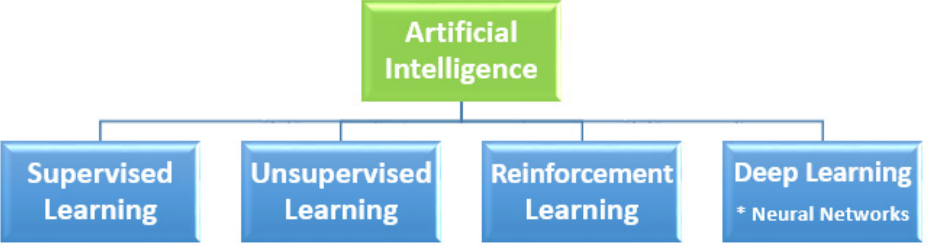
Figure 1. Machine Learning Model A-Z process.